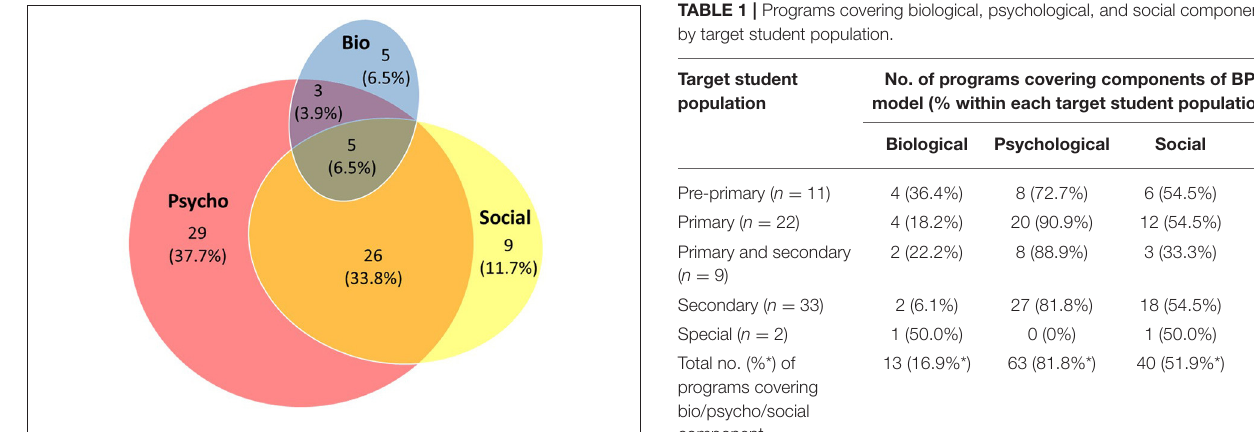
FIGURE 1 | Composition of the 77 school-based well-being programs in Hong Kong with respect to biological, psychological, and social components.